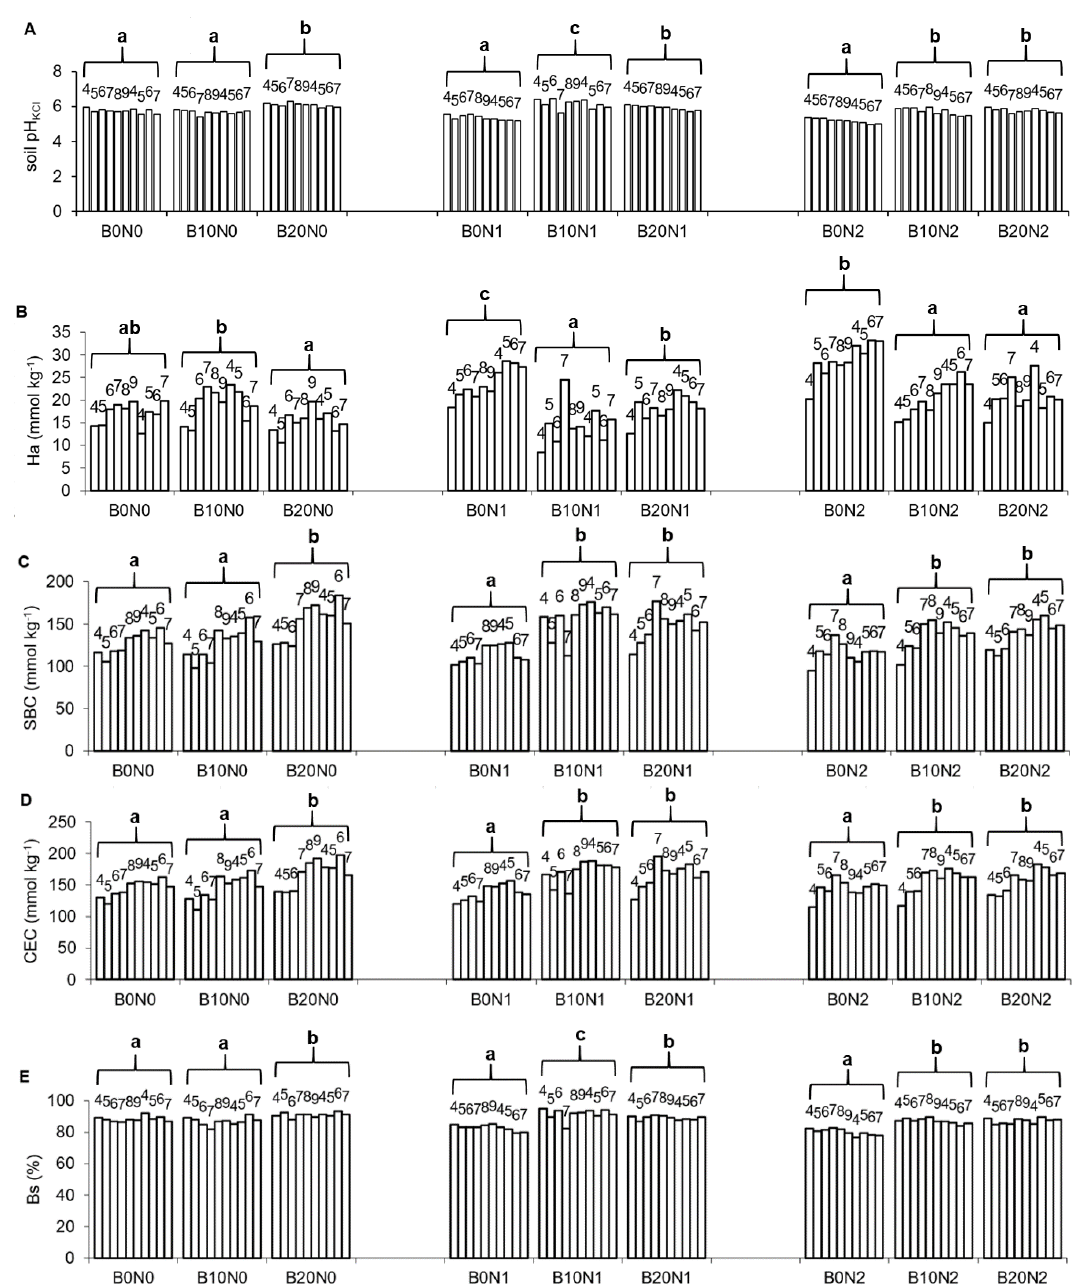
Figure 1. Dynamics of soil pH and sorption parameters during vegetation season in 2017 – 2018: ( A ) soil pH, ( B ) hydrolytic acidity, ( C ) sum of basic cations, ( D ) cation exchange capacity, ( E ) base saturation. Treatments are mentioned in the Material and Methods Section. Vegetation season in 2017 represents April to September and in 2018 from April to July. (4: April, 5: May, 6: June, 7: July, 8: August, 9: September). Different letters (a, b, c) indicate that treatment means are significantly different at p ≤ 0.05 according to the LSD multiple-range test.